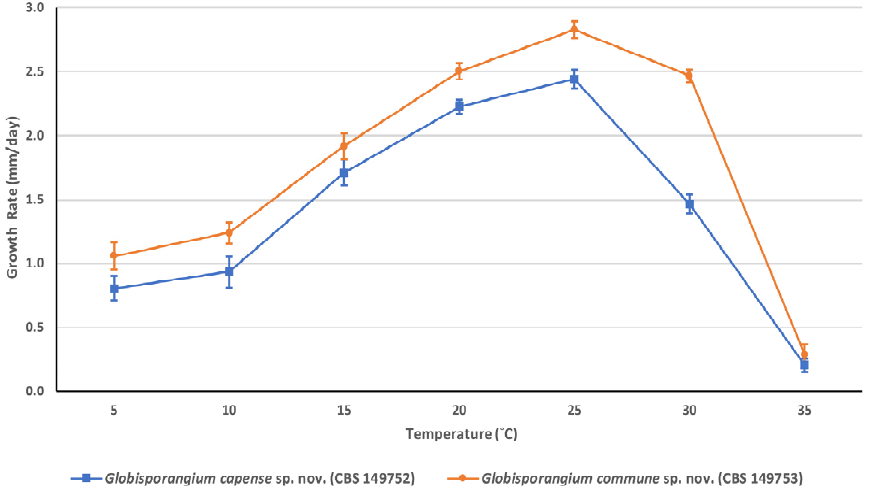
Figure 3. Average radial growth rate of Globisporangium capense sp. nov. and Globisporangium commune sp. nov. per day on PCA at different temperatures. Error bars represent the mean ± standard deviation.